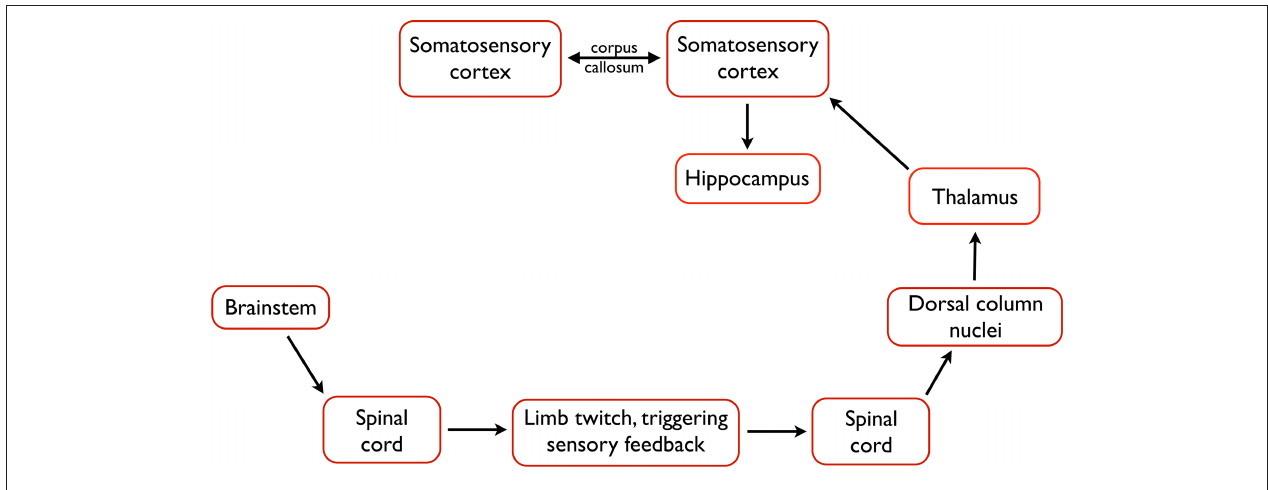
before generating a spindle burst in primary somatosensory cortex. From the cortex, activation is communicated to the hippocampus and, perhaps, to other structures. In addition, interactions between homotopic regions of left and right somatosensory cortex, via the corpus callosum, modulate spindle burst